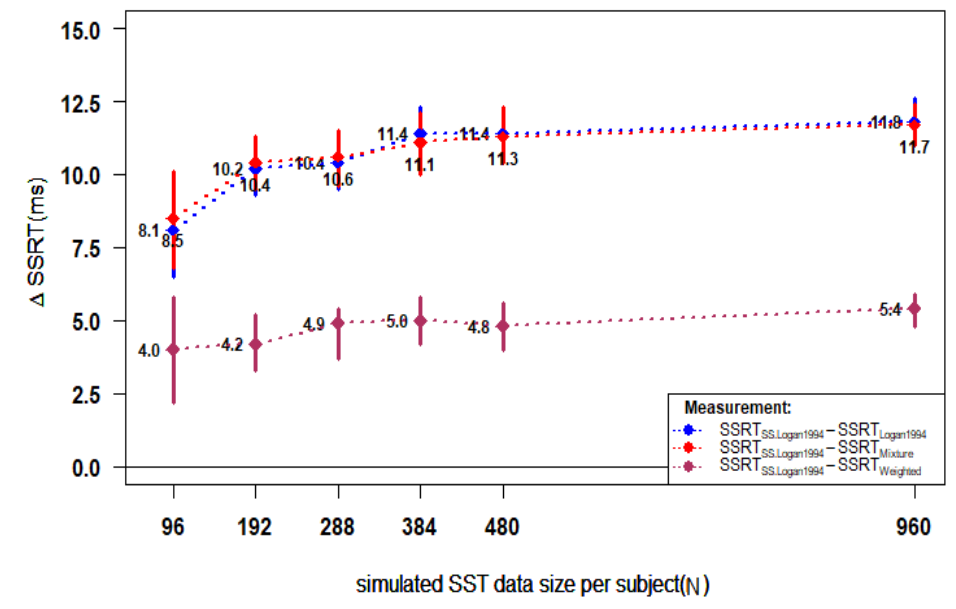
Figure 6. Disparities of simulated SSRT indices by sample size (n =